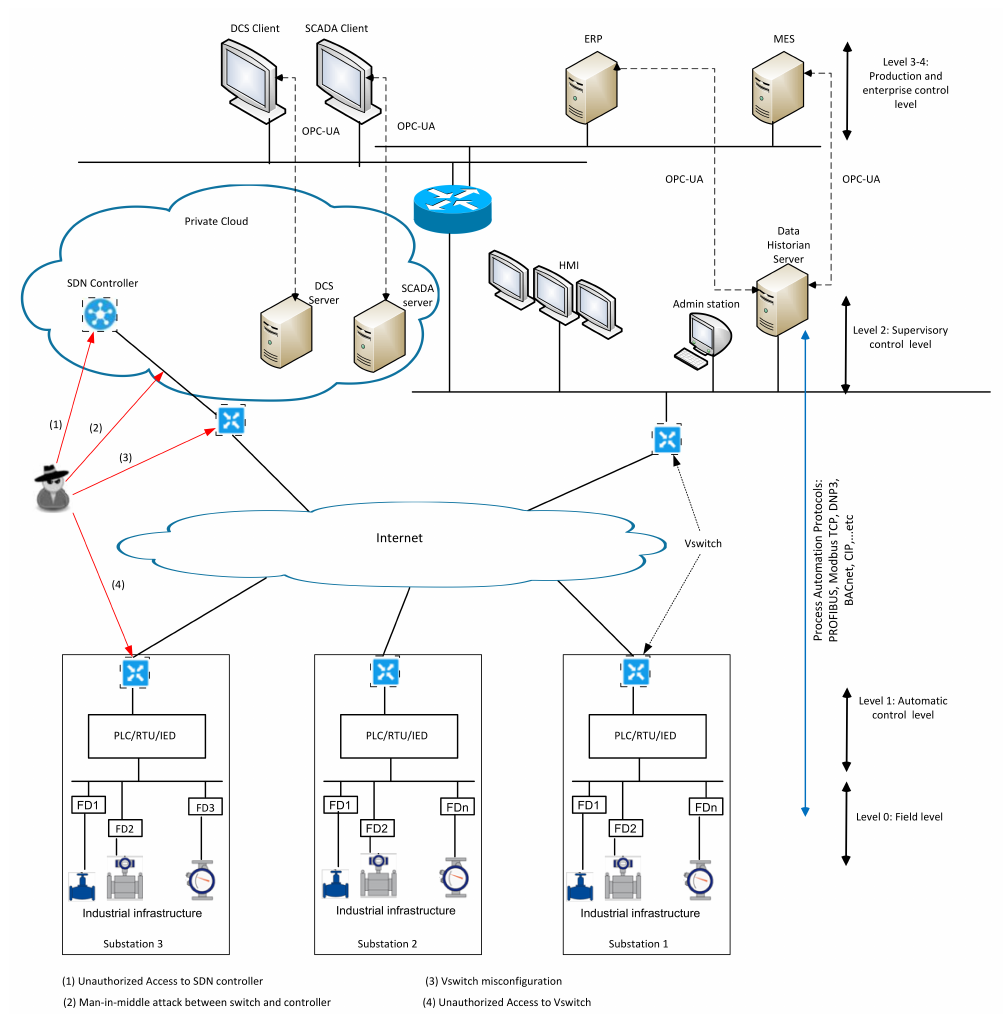
Figure 2. Software-defined networking (SDN)-based ICS